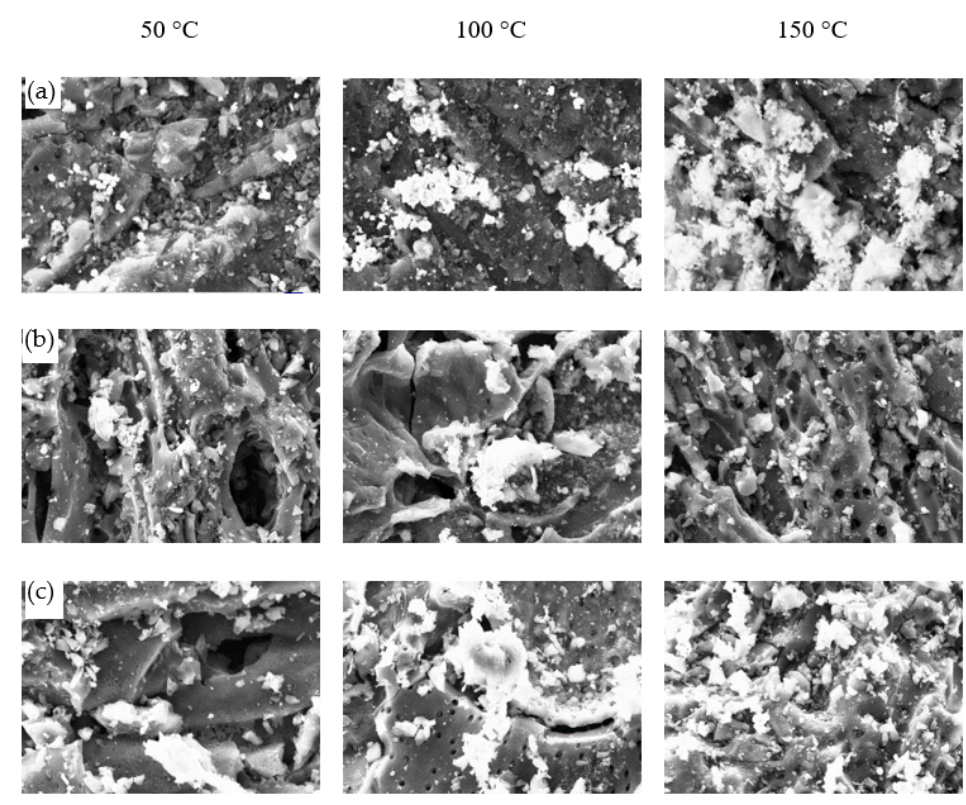
Figure 9. SEM micrographs with 2.5 Kx magnification and a 2 micron scale for ( a ) ZnAc2/ZnO/CAC_DCM, ( b ) ZnAc2/CAC_SI, and ( c ) raw CAC adsorbents at different desorption temperatures.